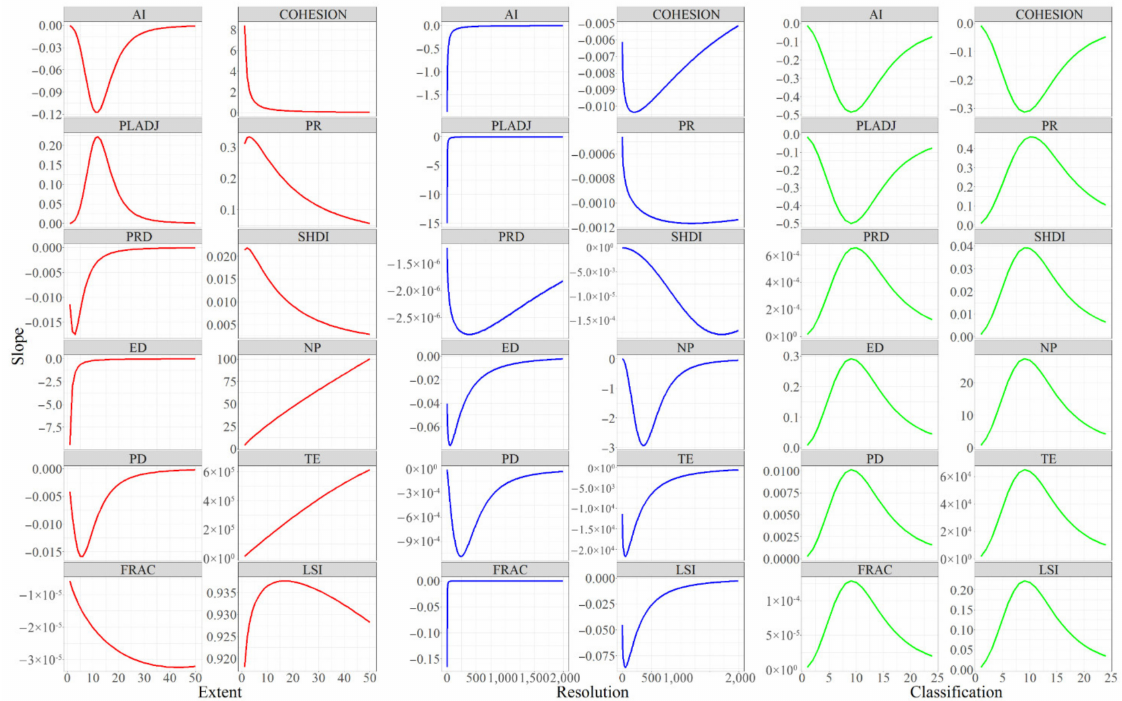
Figure A2. The slop curves of the three scaling logistic growth